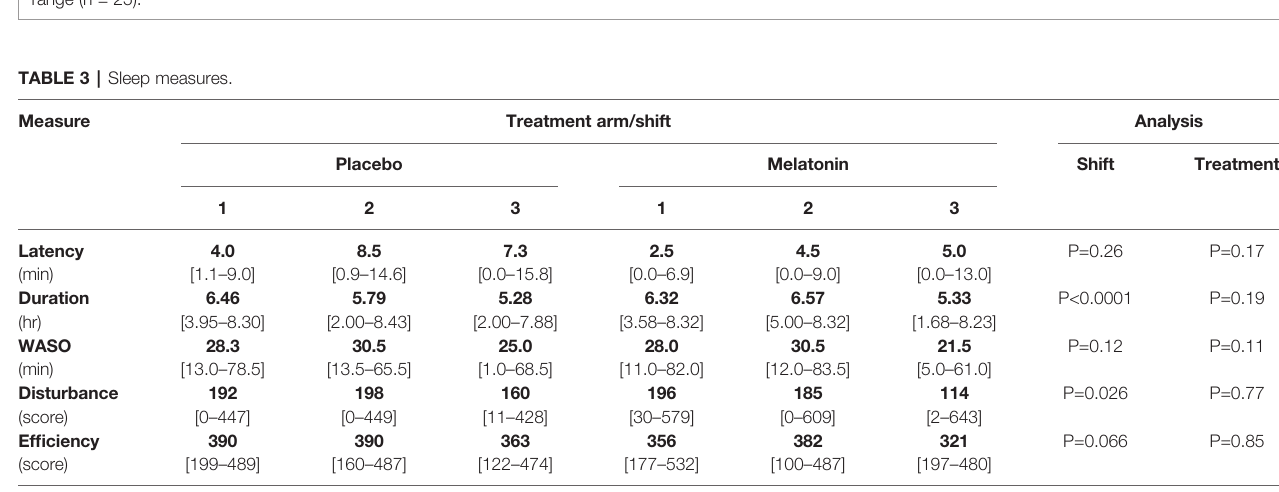
FIGURE 4 | (A) Epworth sleepiness score before, during and after each series of shifts. ESS was signi fi cantly lower before than during and after each shift (P<0.0001 overall) and higher after the shift than during the shift (P = 0.0045 overall). *signi fi cantly lower than during or after shift, p<0.05. (B) Total Epworth sleepiness score for each shift. Scores decreased signi fi cantly over the three shifts (P = 0.0026 overall). Box and whisker plots show median, interquartile, and full range (n =